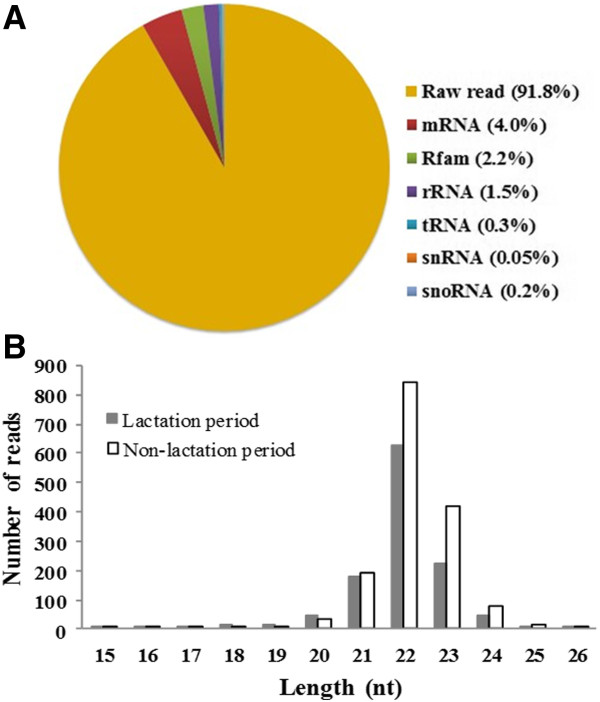
The characteristics of sequencing reads. (A) Count number distribution of the various RNA classes. (B) Length distribution of small RNAs of various lengths (15–26 nt).